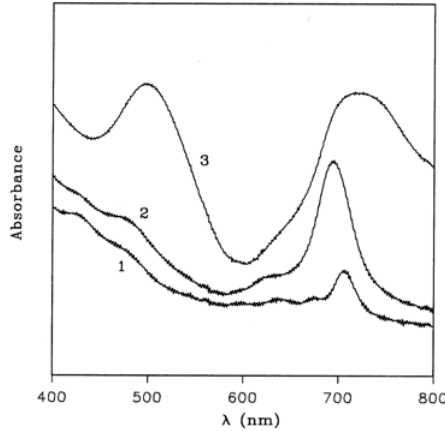
film during oxidation by 100 ppm of NO Figure 3. Spectra of TiPc 2 (1) neutral yellow film; (2) after partial oxidation, green film; and (3) after complete oxidation, red film. Reproduced with the permission from reference